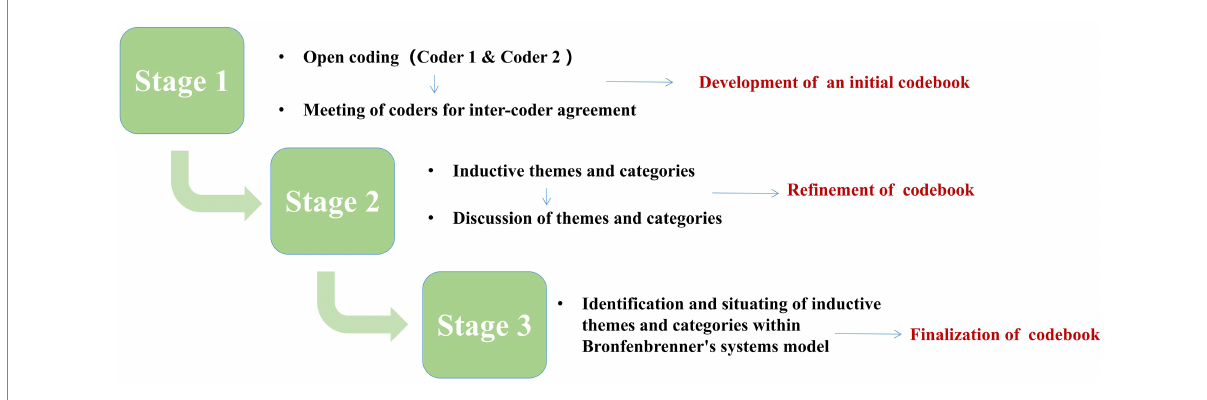
FIGURE 2 Stages of analysis implemented through applied thematic